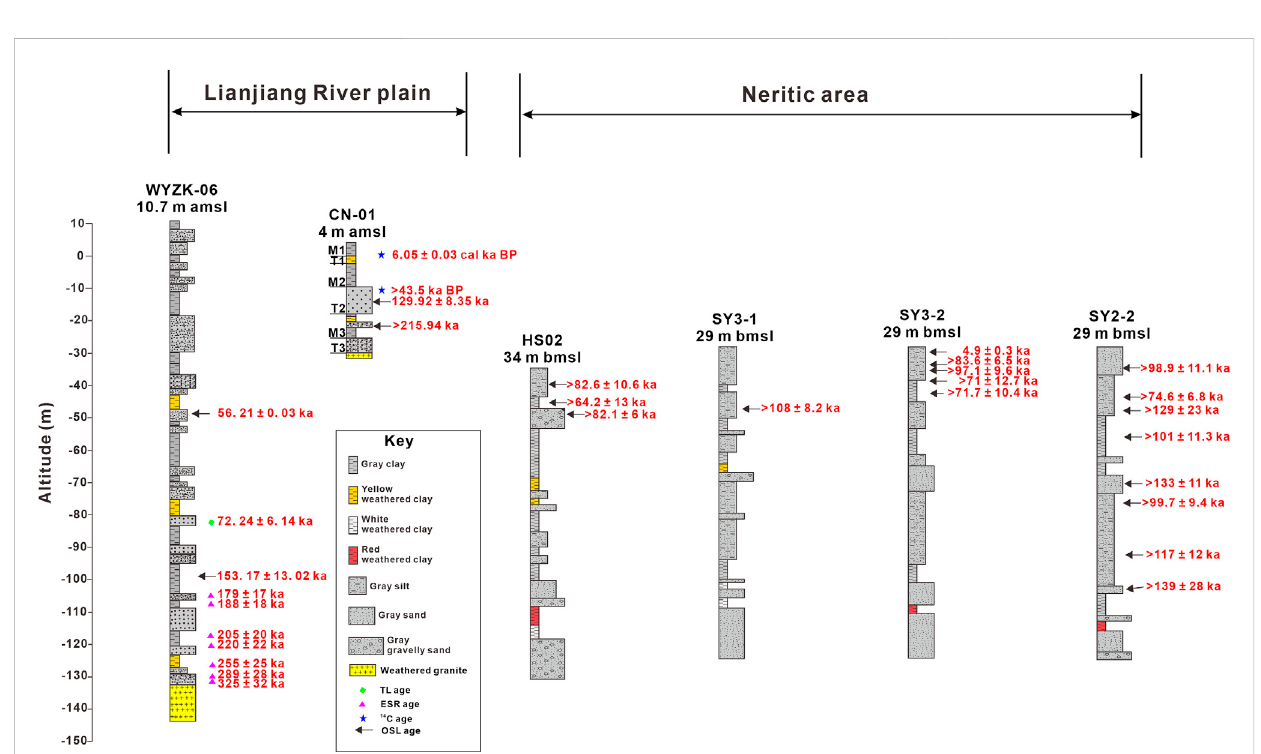
FIGURE 5 The stratigraphic correlation of cores WYZK-06, CN-01, HS02, SY3-1, SY3-2, and SY2-2. Core HS02, SY3-1, SY3-2, and SY2-2 were obtained during thisstudy,whilecoreWYZK-06wasobtainedfromSongetal.(2012),andcoreCN-01wasobtainedfromTangetal.(2018).Corealtitudeisrepresentedin the Y -axis as below mean sea level (bmsl) and above each core stratigraphy as above mean sea level